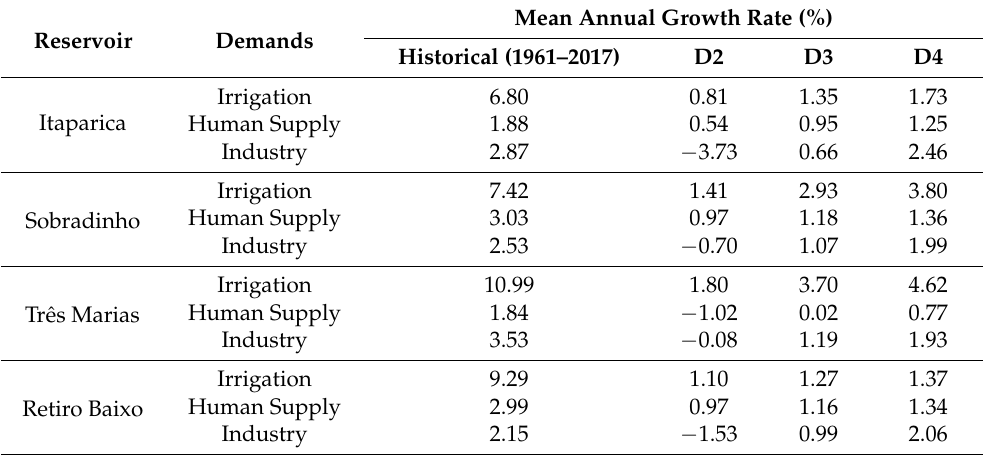
Table 5. Mean annual growth rate of consumptive demands.